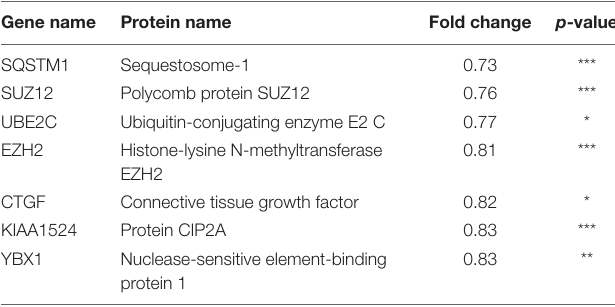
TABLE 2 | Cancer stem cell-related and downregulated proteins by NEDD4 knockdown in